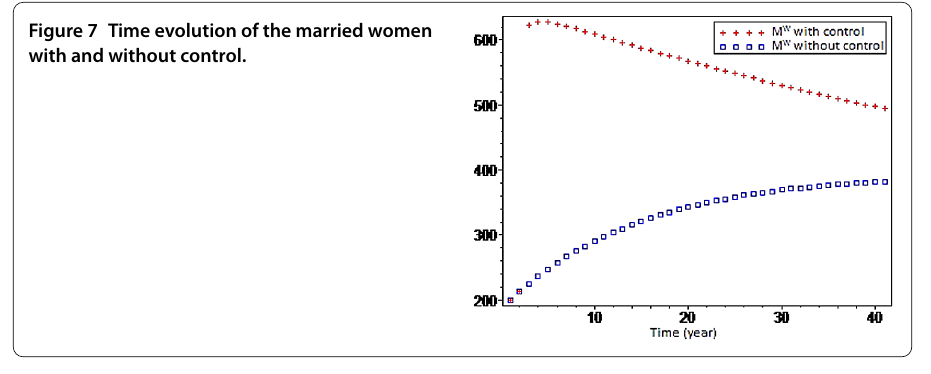
Figure 8 Time evolution of the divorced men with and without